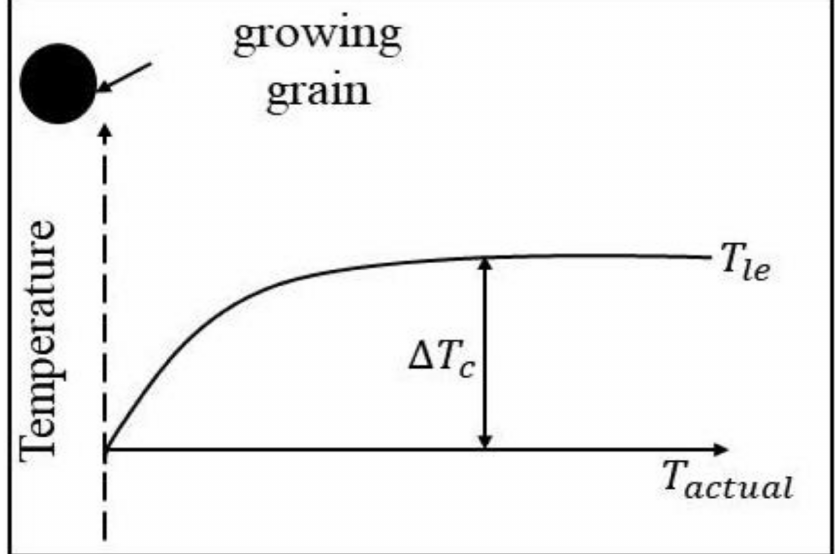
Figure 1. A representation of the constitutive undercooled zone in front of the growing equiaxed grains obtained by assuming no contribution from thermal subcooling or latent heat, as well as a negligible thermal gradient (T actual is a constant value). Figures taken from Acta Metallurgica [17] with